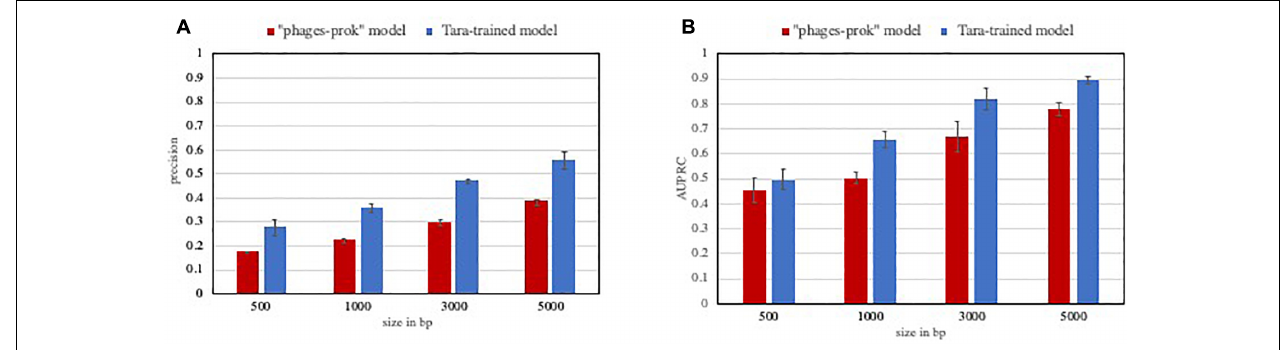
FIGURE 2 | Performance of classifiers on a low viral content evaluation set. The precision (A) and Area under the precision-recall curve (AUPRC) (B) was calculated for VirFinder “phages-prok” model and a Tara-trained model on an imbalanced marine evaluation set. The evaluation set is composed of sequences from genomes from phages and prokaryotes isolated in marine ecosystems, downloaded from Genbank and the Patric database, respectively, and the sequences were broken down to 5000, 3000, 1000, and 500 bp (see methods in Supplementary File S1 and list of genomes available in Supplementary File S2 ). The mean precision (A) and AUPRC (B) was obtained on three evaluation sets composed of 100 viral sequences and 1900 non-viral sequences. The error bars correspond to the standard deviation on these three measures.